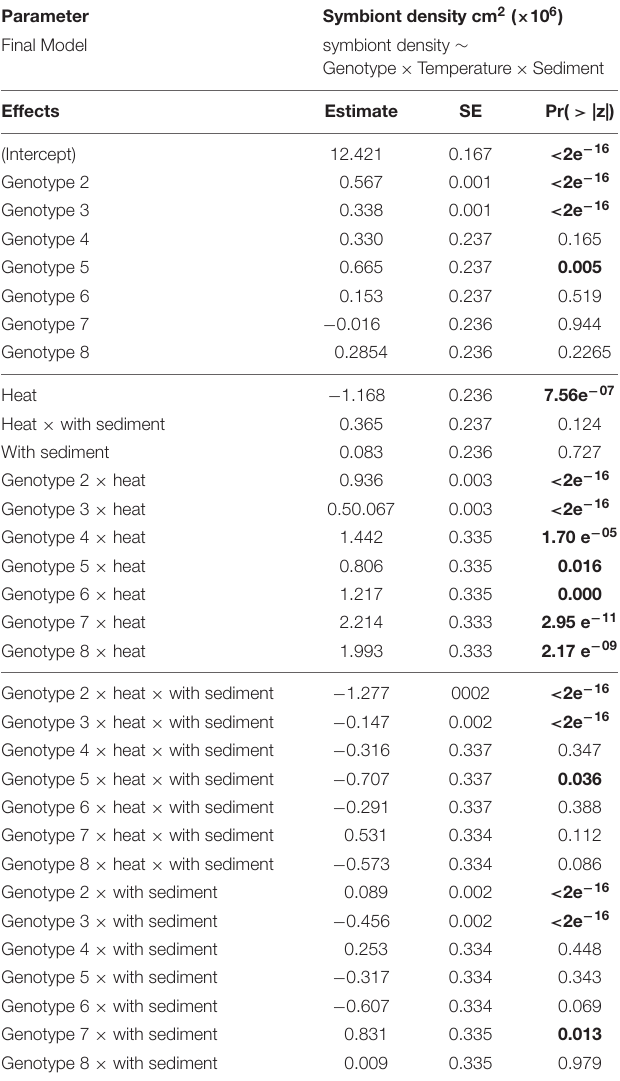
TABLE 3 | Results from generalized linear mixed-effects model on the effects of different treatments on average symbiont density, using control as the reference category (intercept).